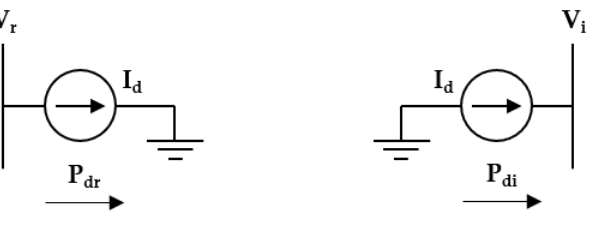
Figure 1. HVDC fault calculation model (PQ bus mode).